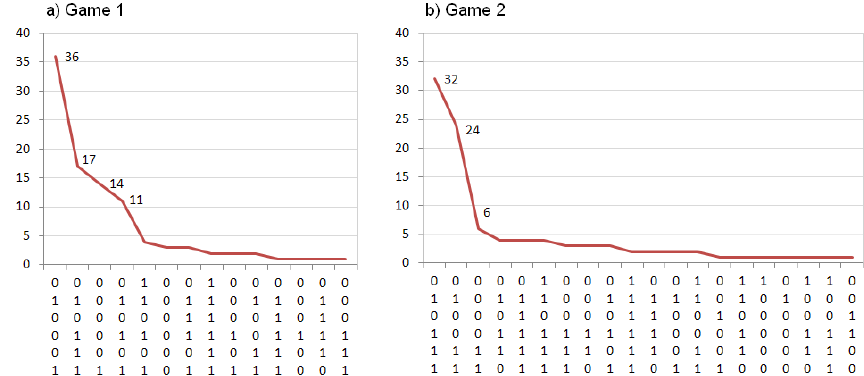
Figure 4. Combinations of ‘yes’ (=1) and ‘no’ (=0) answers (x-axis) observed during the six rounds of Game 1 (left) and Game 2 (right) and the number of participants (out of 98 participants) having shared the same combination (y-axis). The first combination represents the ‘ensemble result’.